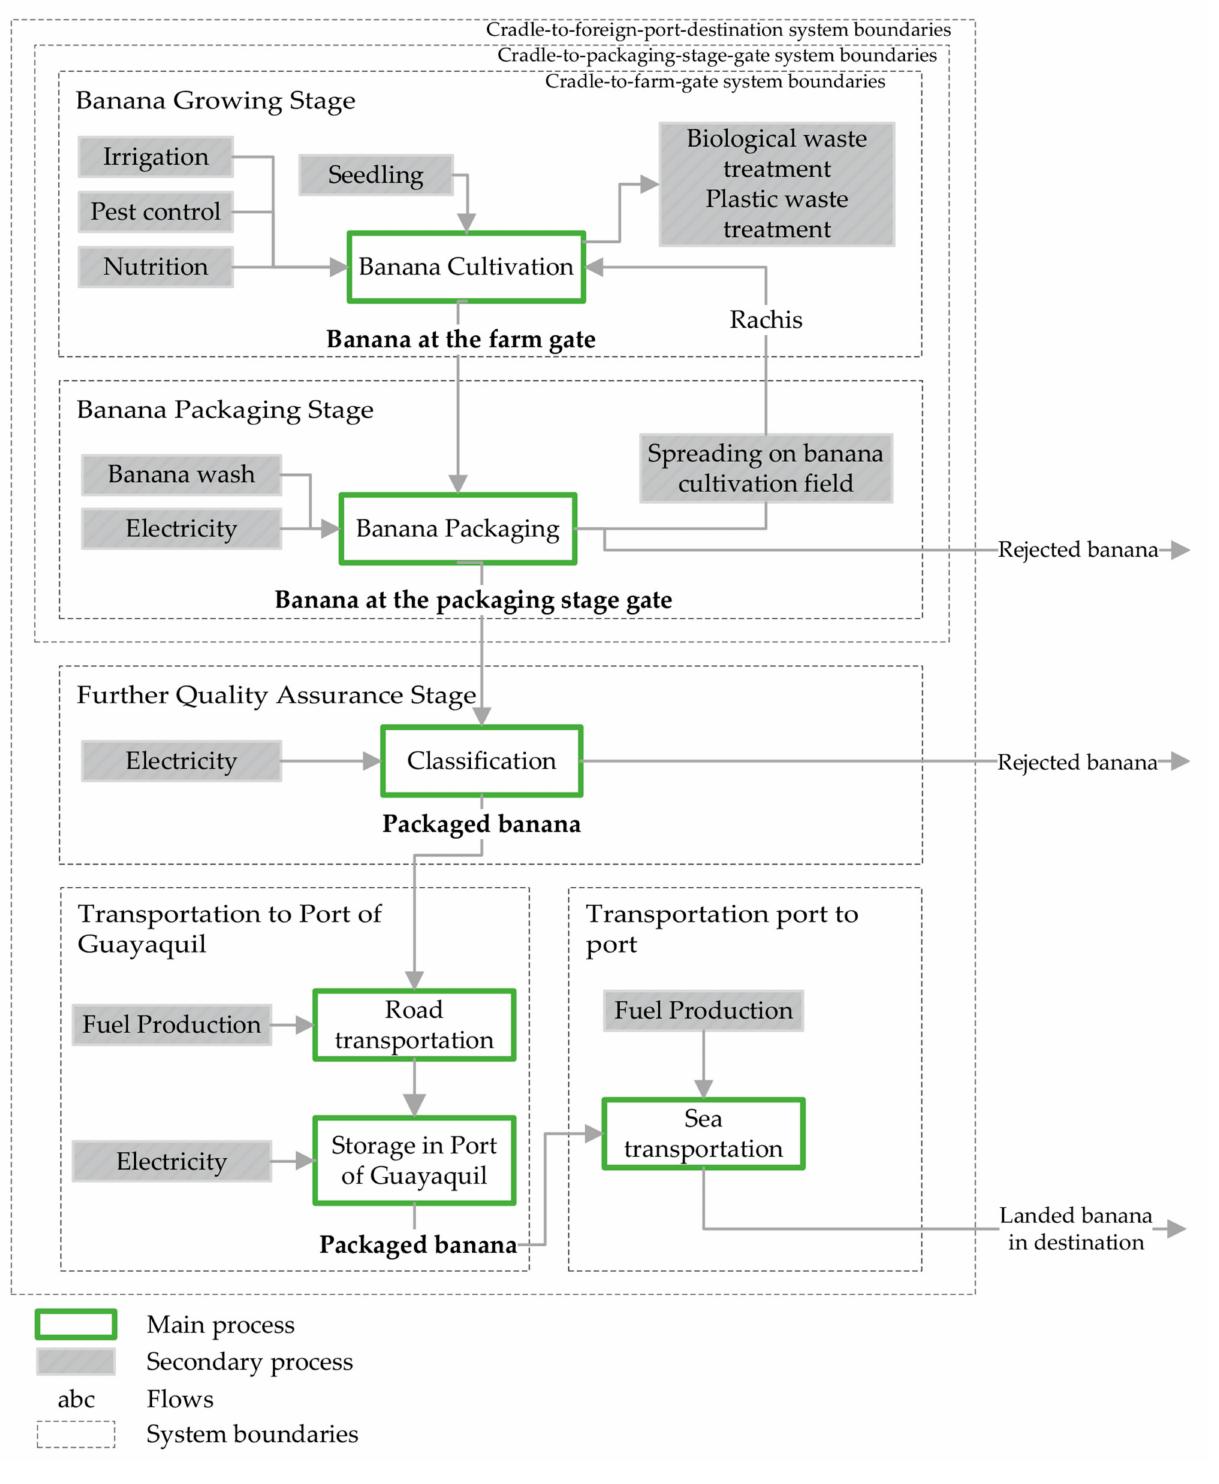
Figure 1. System boundaries at cradle-to-farm-gate, cradle-to-packaging-stage-gate, and cradle-to- foreign-port-destination for the studied